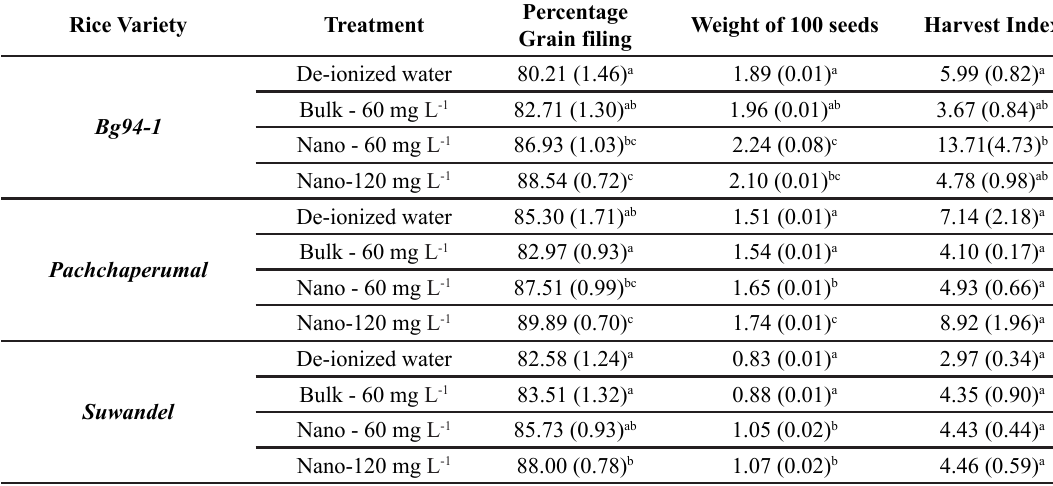
Table 3: Descriptive statistics of the yield/Reproductive characteristics, percentage grain filling weight of 100 seeds and Harvest Index based on treatment and rice